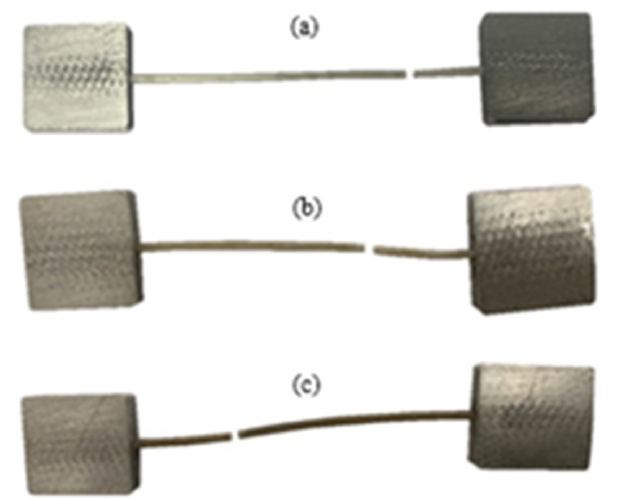
Figure 10. Images of uniaxially loaded PLA filaments. Representative samples ( a – c ) show that failure occurred at different locations but at a substantial distance from the loaded ends and confirm the absence of necking.